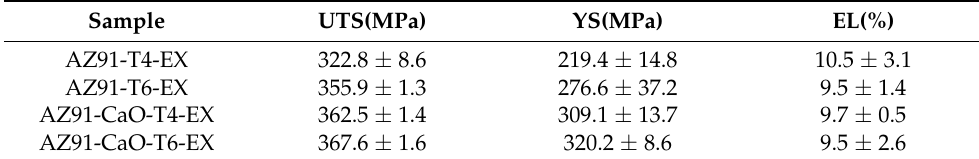
Figure 5. Typical tensile engineering stress-strain curves ( a ) and tensile properties of the as-cast and extruded alloys ( b ). Table 3. Tensile test data.